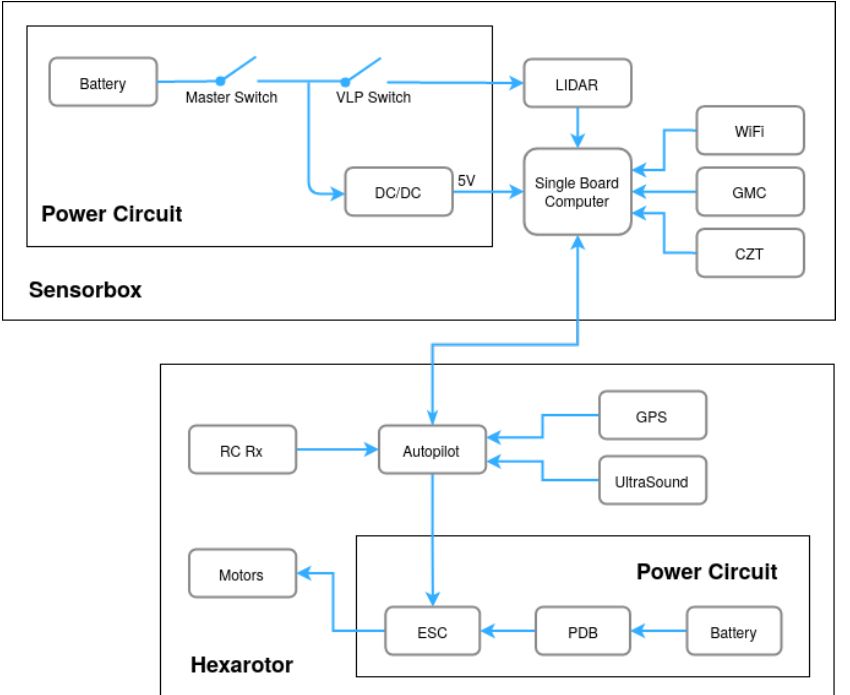
Figure 8. HW architecture of the Drone and